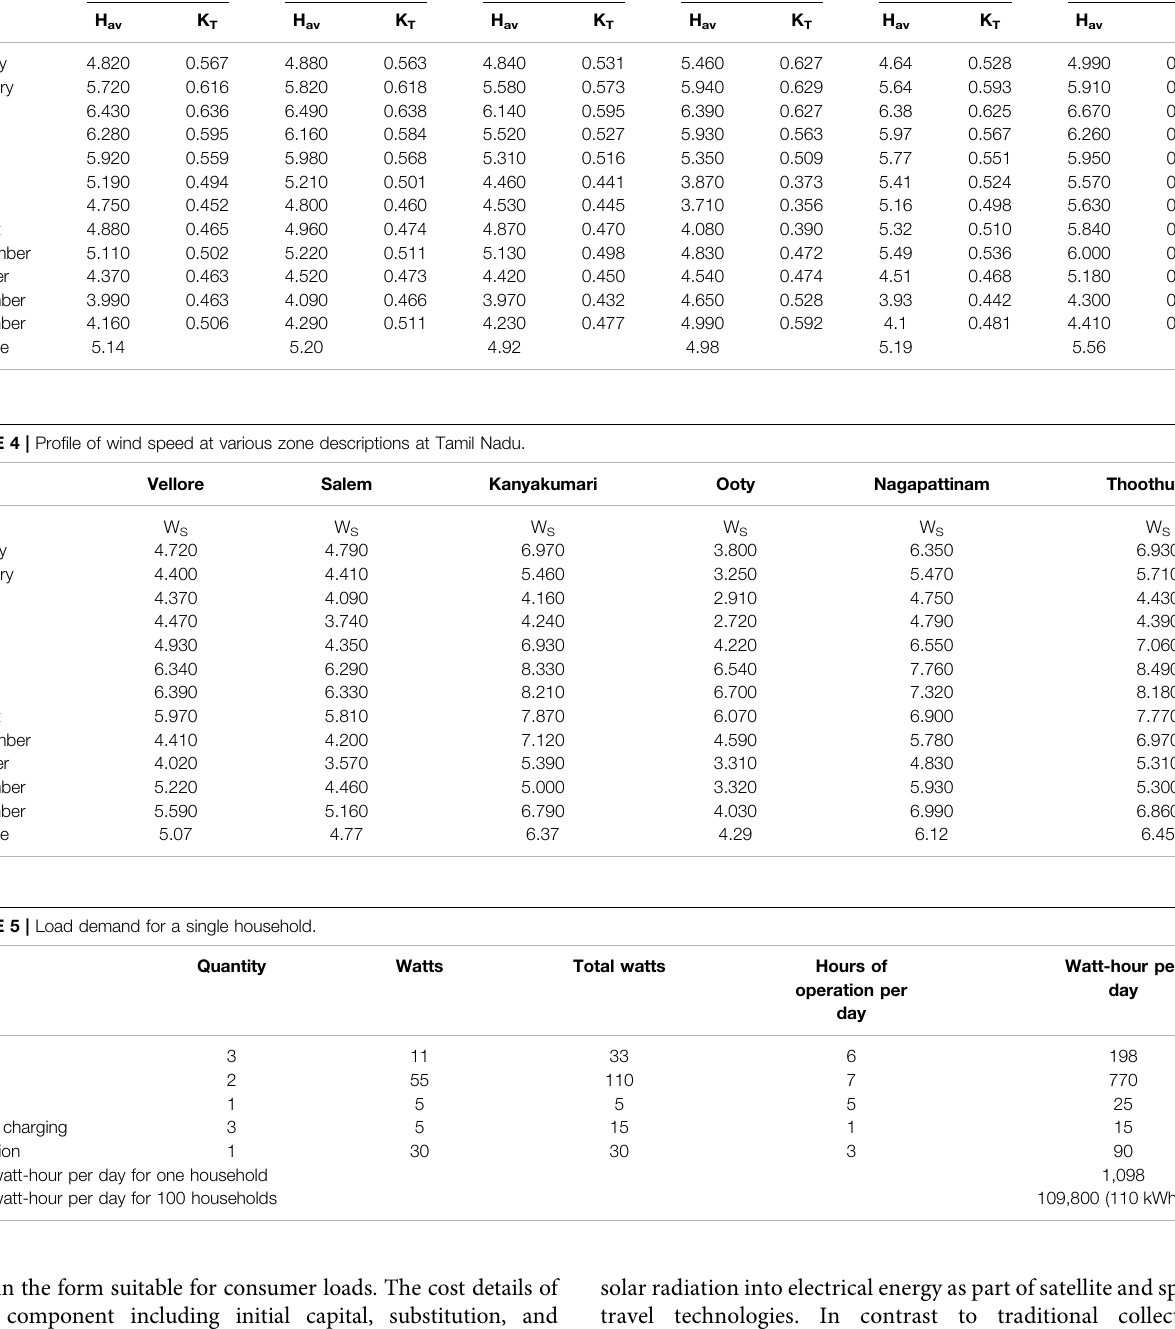
TABLE 3 | Meteorological data of solar radiation and clearness index for various Tamil Nadu locations. Month Vellore